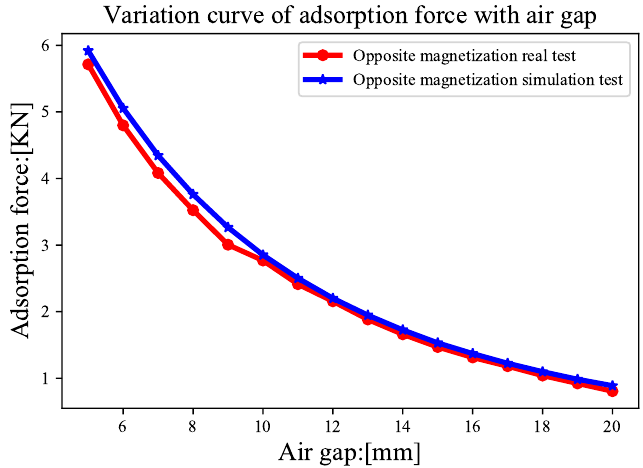
Figure 20. Comparison of opposite magnetization adsorption forces.